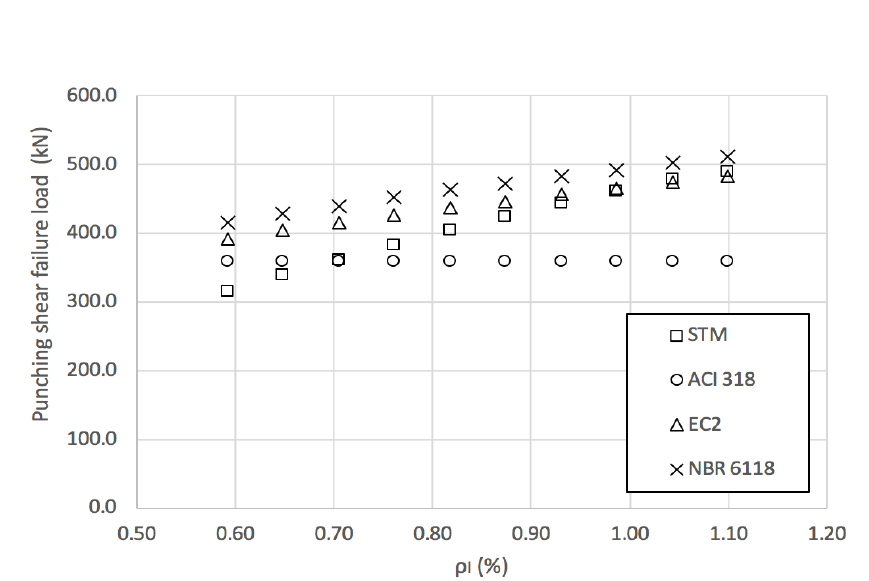
Figure 7. Longitudinal reinforcement rate versus punching shear resistance - Group A